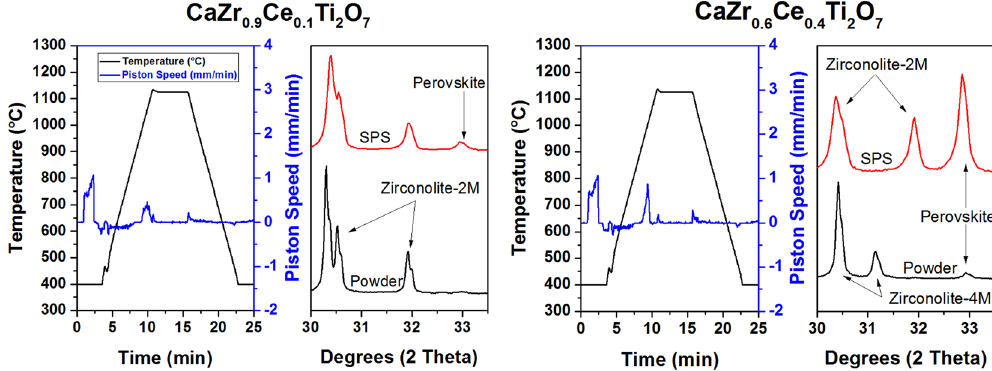
Figure 5. Temperature profile and piston speed during SPS of CaZr 0.9 Ce 0.1 Ti 2 O 7 and CaZr 0.6 Ce 0.4 Ti 2 O 7 including XRD comparison of the powder and resulting SPS pellet.